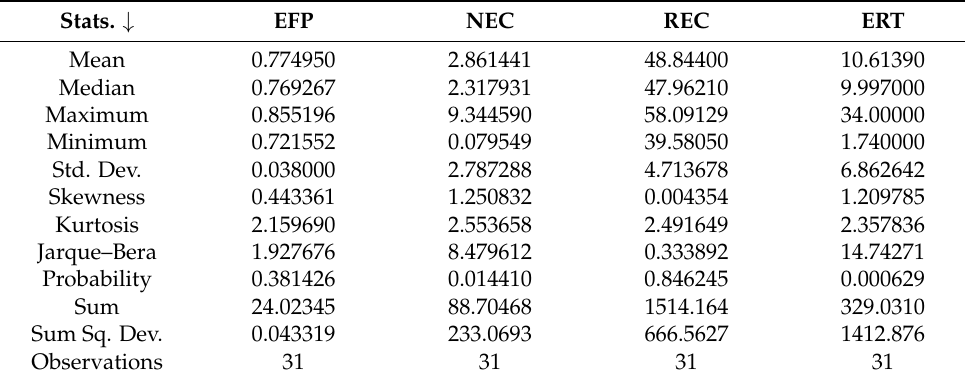
Table 3. Descriptive statistics of the study variables.